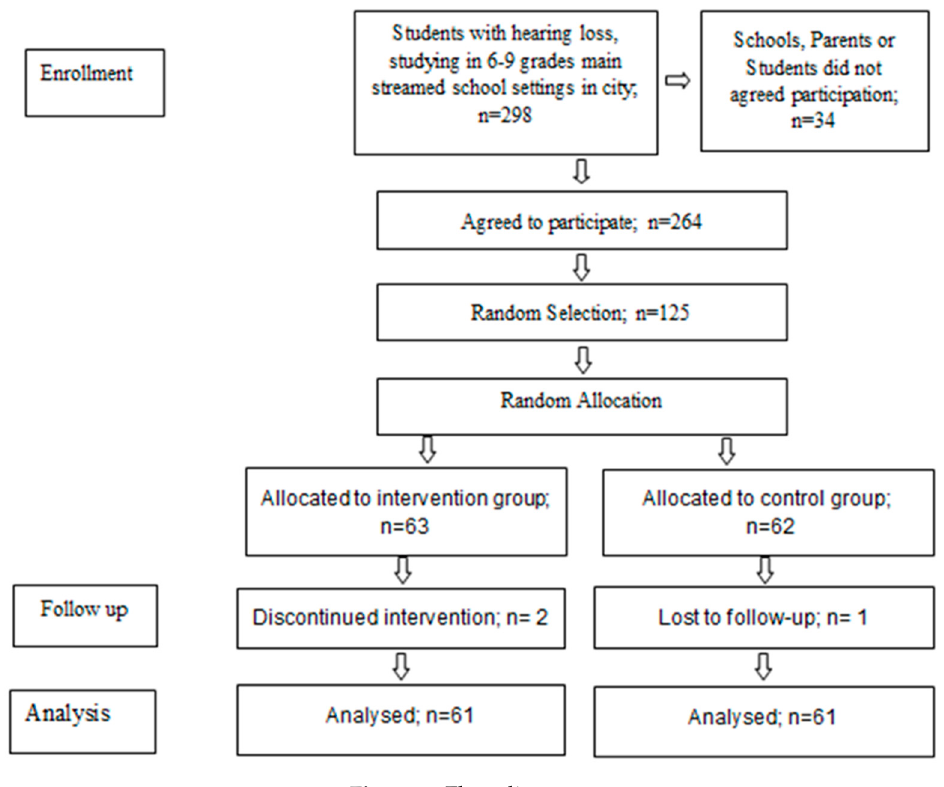
Figure 1. Flow Figure 1. Flow diagram.